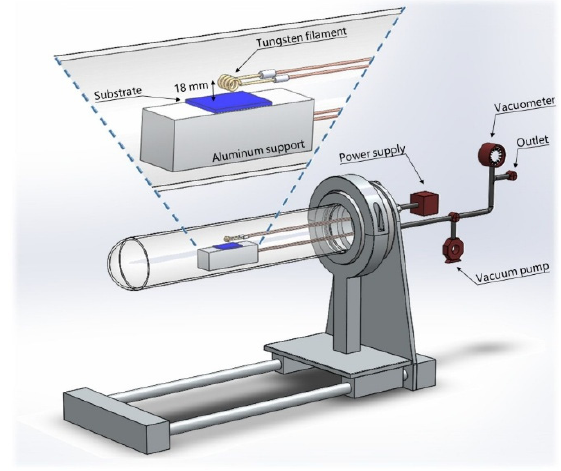
Figure 1. Schematic of the HFCVD reactor. Magnification shows the filament-substrate arrangement for a-WO 3 synthesis.